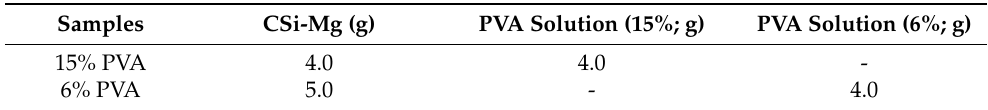
Table 1. Chemical composition of the